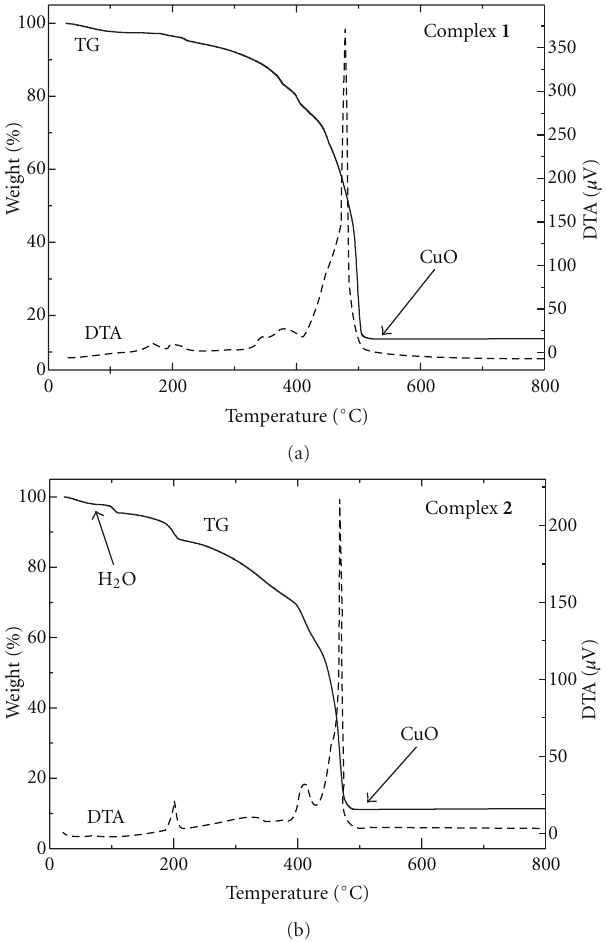
Figure 2: TG and DTA curves showing the thermal behaviour of complex 1 (a) and 2